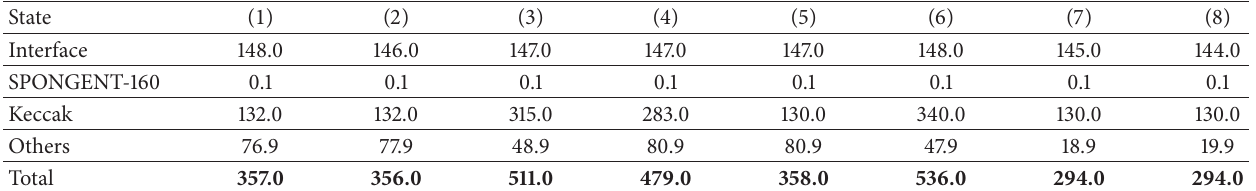
Table 5: Simulated power consumption of the cryptographic block using Keccak ( 𝜇